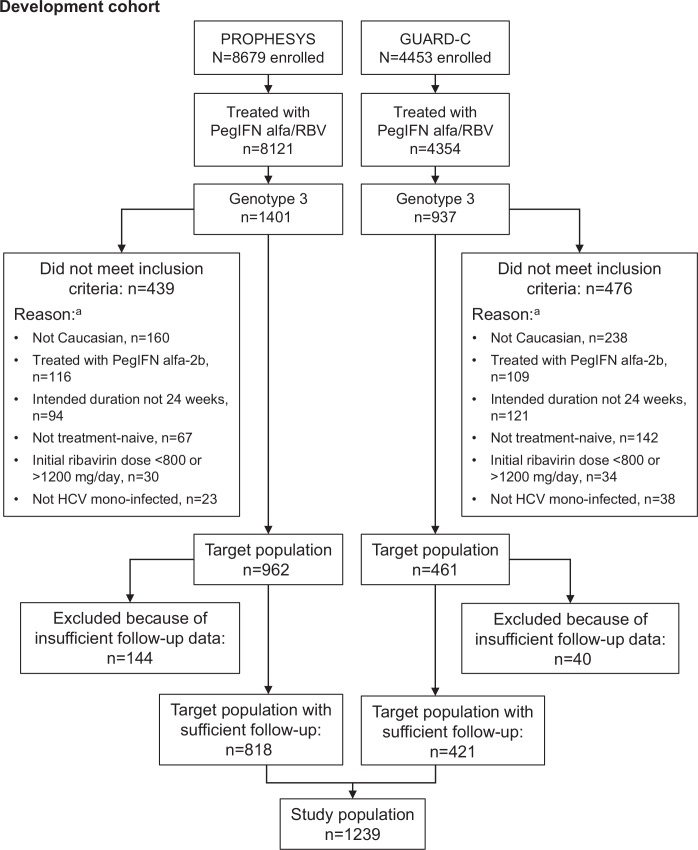
Patient selection for the development cohort.